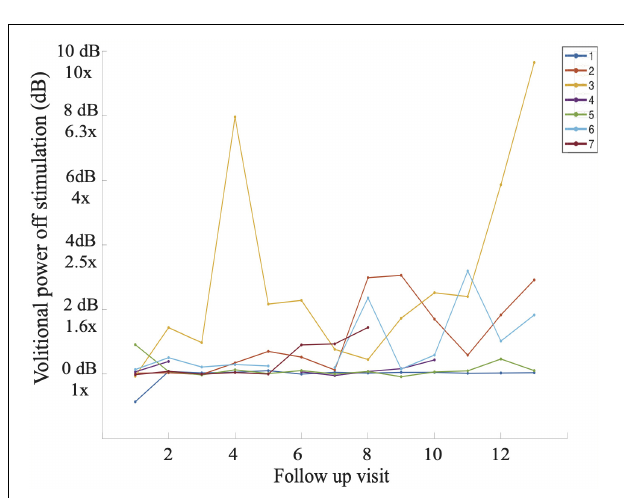
FIGURE 7 | Average volitional power without stimulation (dB) at each study follow-up visit including all seven participants. It is apparent that Subject 3 demonstrated volitional movement the earliest in the study (follow-up visit 4) and with the greatest magnitude on sEMG, reaching volitional muscle activity 10 times greater (1000%) than that at baseline on follow-up visit 13.